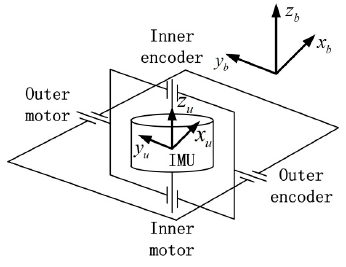
Figure 1. Structure of the dual-axis RINS. Table 1. Specifications of main components of RINS.